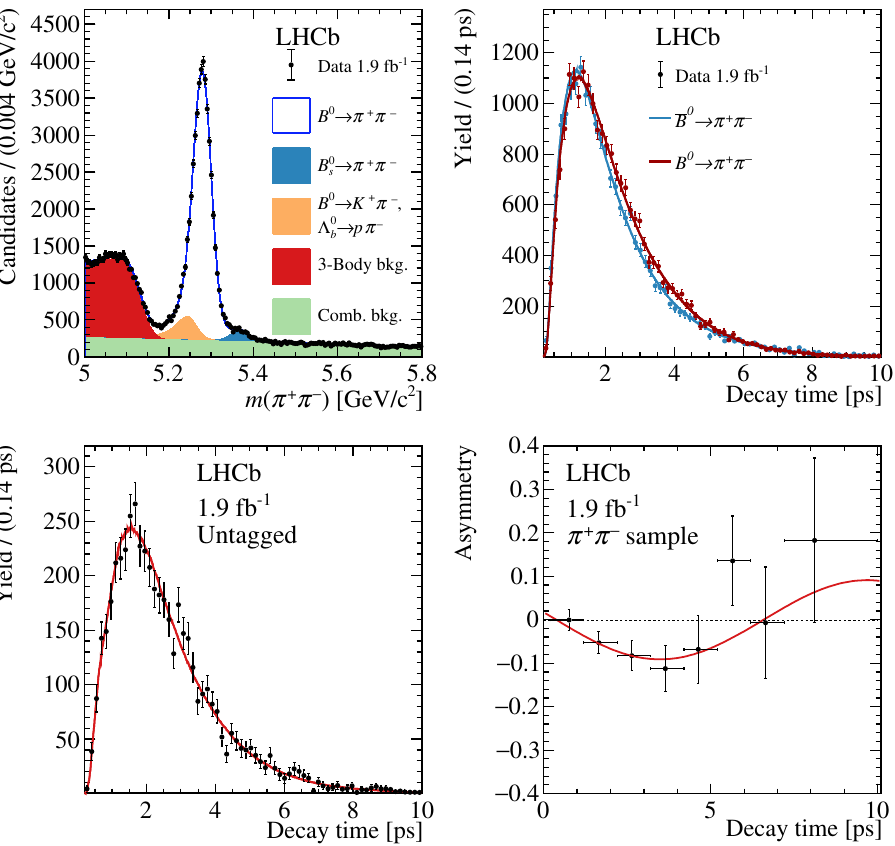
Figure 7 . Distributions of the (top left) (cid:25) + (cid:25) (cid:0) invariant mass, (top right) decay time for tagged B 0 mesons, (bottom left) decay time for untagged B 0 mesons and (bottom right) asymmetry for the B 0 (cid:25) + (cid:25) (cid:0) decays. The individual components are shown for the invariant-mass spectrum ! while only tagged background-subtracted candidates are shown in the decay-time spectrum. The (cid:12)t results to the di(cid:11)erent distributions are overlaid. The various components contributing to the invariant mass model are drawn as stacked